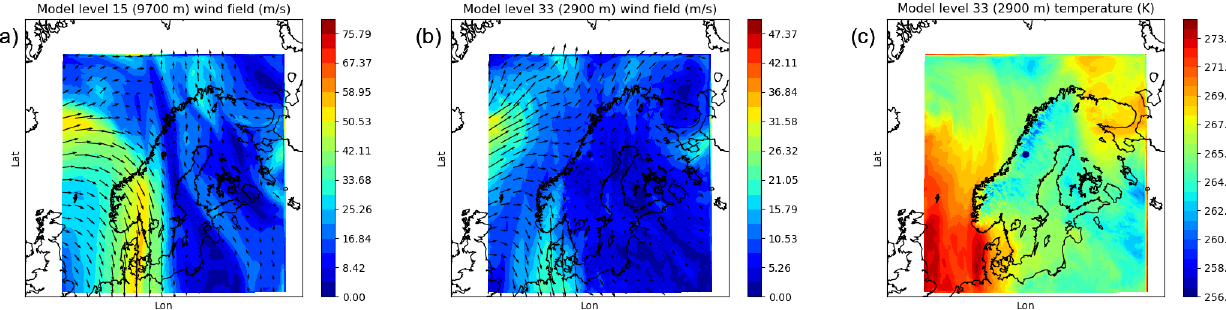
Figure 8. Wind (a, b) and temperature (c) field of + 3h forecast launched on 25 May 2020 at 03:00UTC and valid on 25 March 2020 at 06:00UTC. Also shown is the horizontal location of a single Aeolus HLOS observation with a dot.